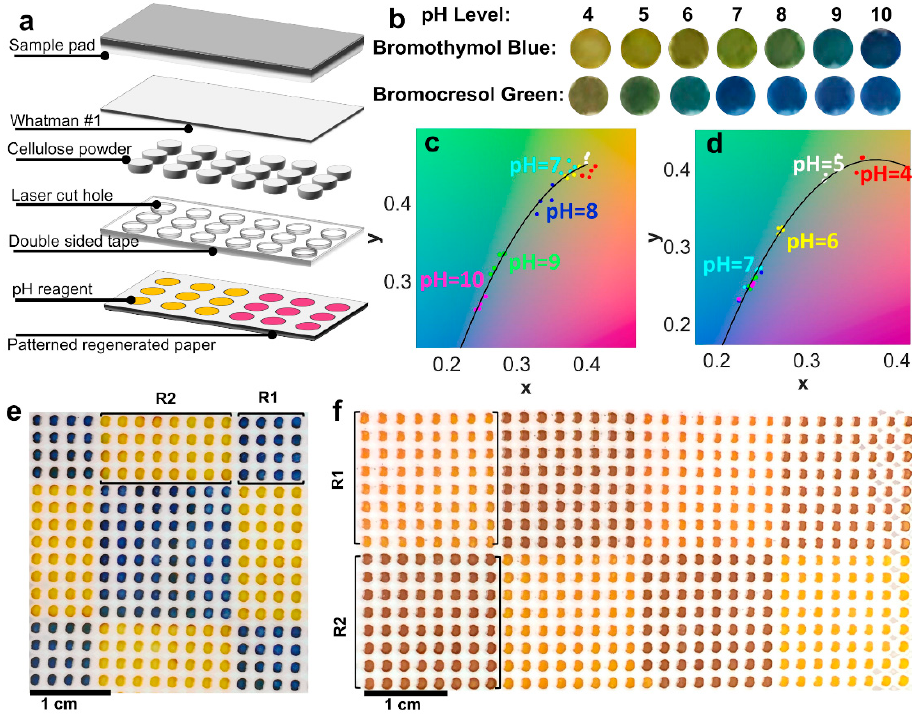
Figure 6. High-resolution and multiplex paper-based microfluidic analytical device. ( a ) Layers and fabrication steps of the high-resolution paper-based microfluidic device. ( b ) Color change of the indicators, i.e., bromothymol blue and bromocresol green, for a range of pH 4 to 10. ( c , d ) Calibration curves for determining pH of the solutions by two indicators, bromothymol blue ( c ) and bromocresol green ( d ) using CIExyY color space. ( e ) Images of a device with 256 detection zones after applying the pH 10 sample to the sample pad. Using the technical pen and pen plotter, the detection zones are automatically filled with bromothymol blue (R1) and methyl red (R2) pH indicators with any given arbitrary pattern. ( f ) Photograph of a device with 512 detection zones filled with bromothymol blue (R1) and methyl red (R2) pH indicators, after applying the pH 4 sample to the sample pad.